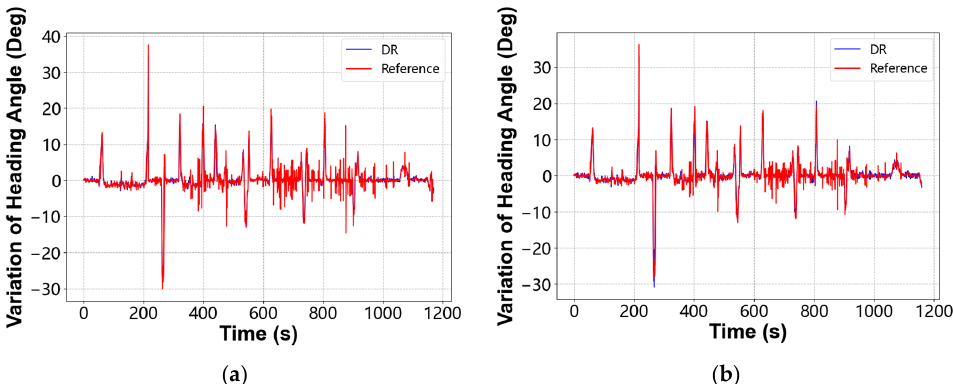
Figure 3. Variation of heading angle. ( a ) Smartphone Huawei P30; ( b ) Smartphone Huawei P40.